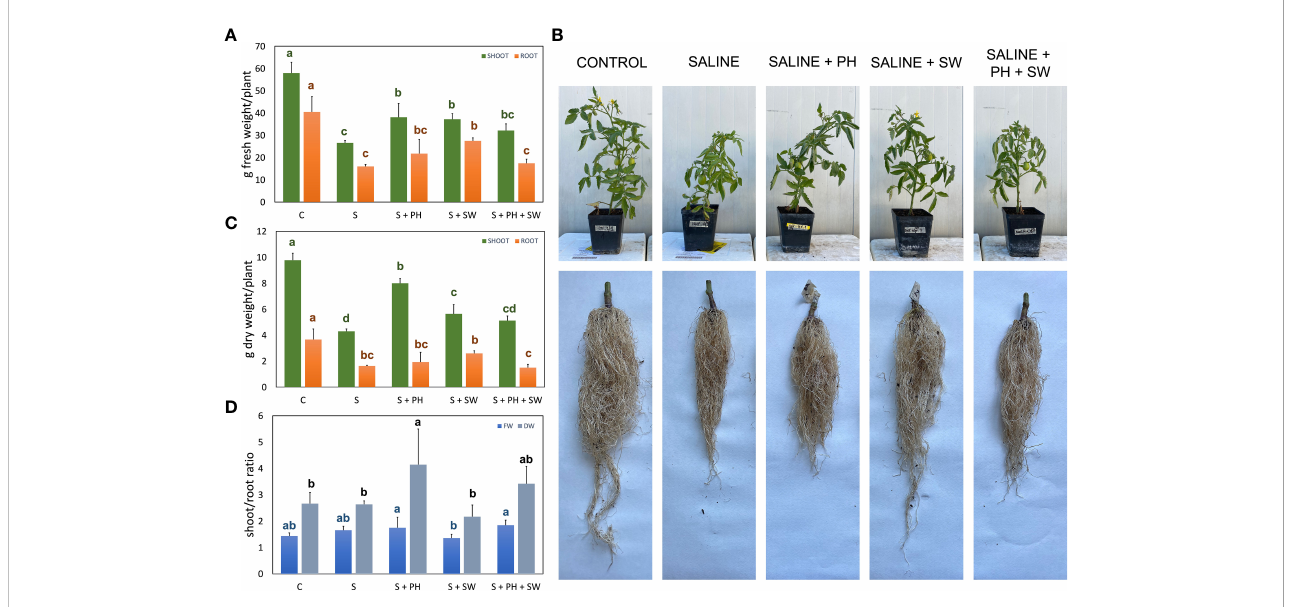
FIGURE 1 Morphological measurements of tomato shoot and root organ parts, affected by salinity stress (S) and treated with biostimulants i.e., protein hydrolysate (PH), seaweed extracts (SW), and their combination PH + SW, compared to the control non-stressed plants (C) . In the panels they show (A) fresh weight, (B) dry weight, and (C) the shoot/root ratio offresh and dry weights for both tomato shoot and roots. In (D) shows the image of the aerial parts and roots after cleaning. Error bars indicate standard errors ( n = 3). Different letters indicate signi fi cant differences according to Tukey ’ s multiple-range test (p = 0.05).